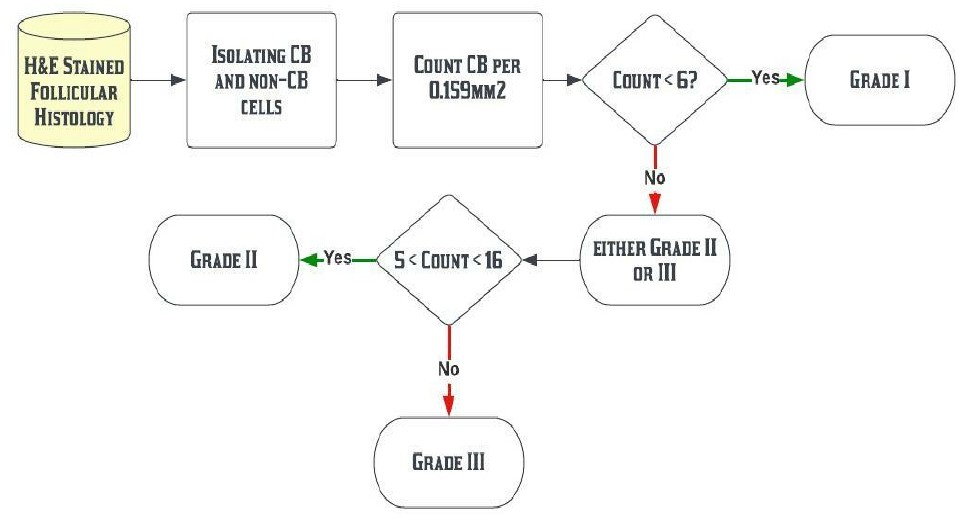
Figure 2. WHO classification of Follicular histology.